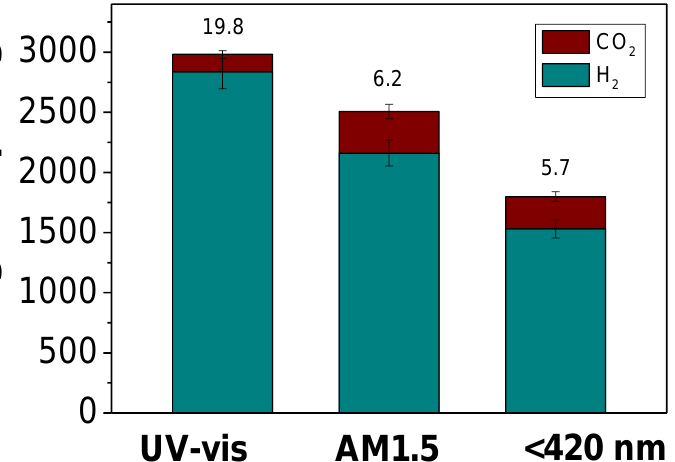
Figure 12. Evolved gases over the influence of the light irradiation source with Pt@UiO-66(Zr)-NH 2 . Reaction conditions: Photocatalyst (5 mg), H 2 O:glycerol mixture (20 mL; 14 vol%), reaction time 3 h, irradiation source as indicated, 35 °C.